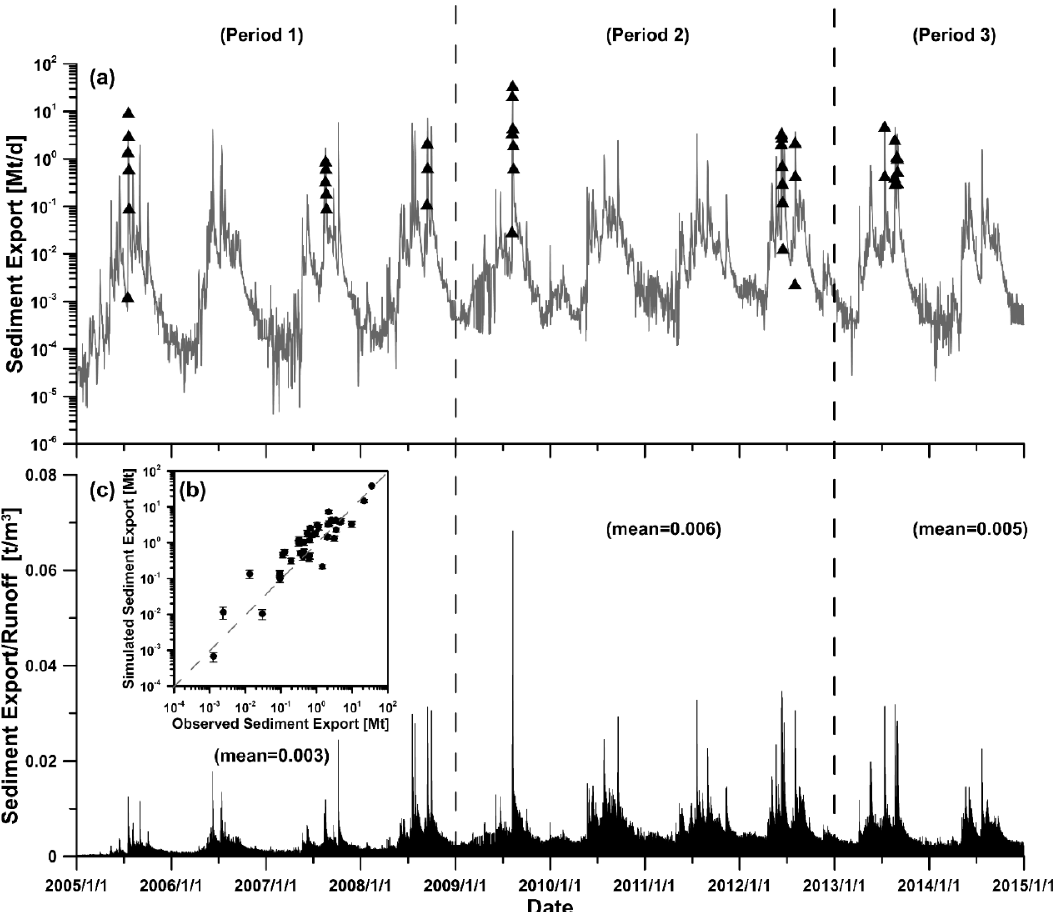
Figure 6. ( a ) Simulated time-series sediment export (Mt day − 1 ) with the observed sediment export (black triangle) on it, and ( c ) the ratio of simulated sediment export to river runoff (t m − 3 ). The relation between the simulated sediment export and the observed is shown in ( b ), and the error bars represent the 2-fold standard deviation of the simulated ranges among the 23 non-inferior parameter sets.